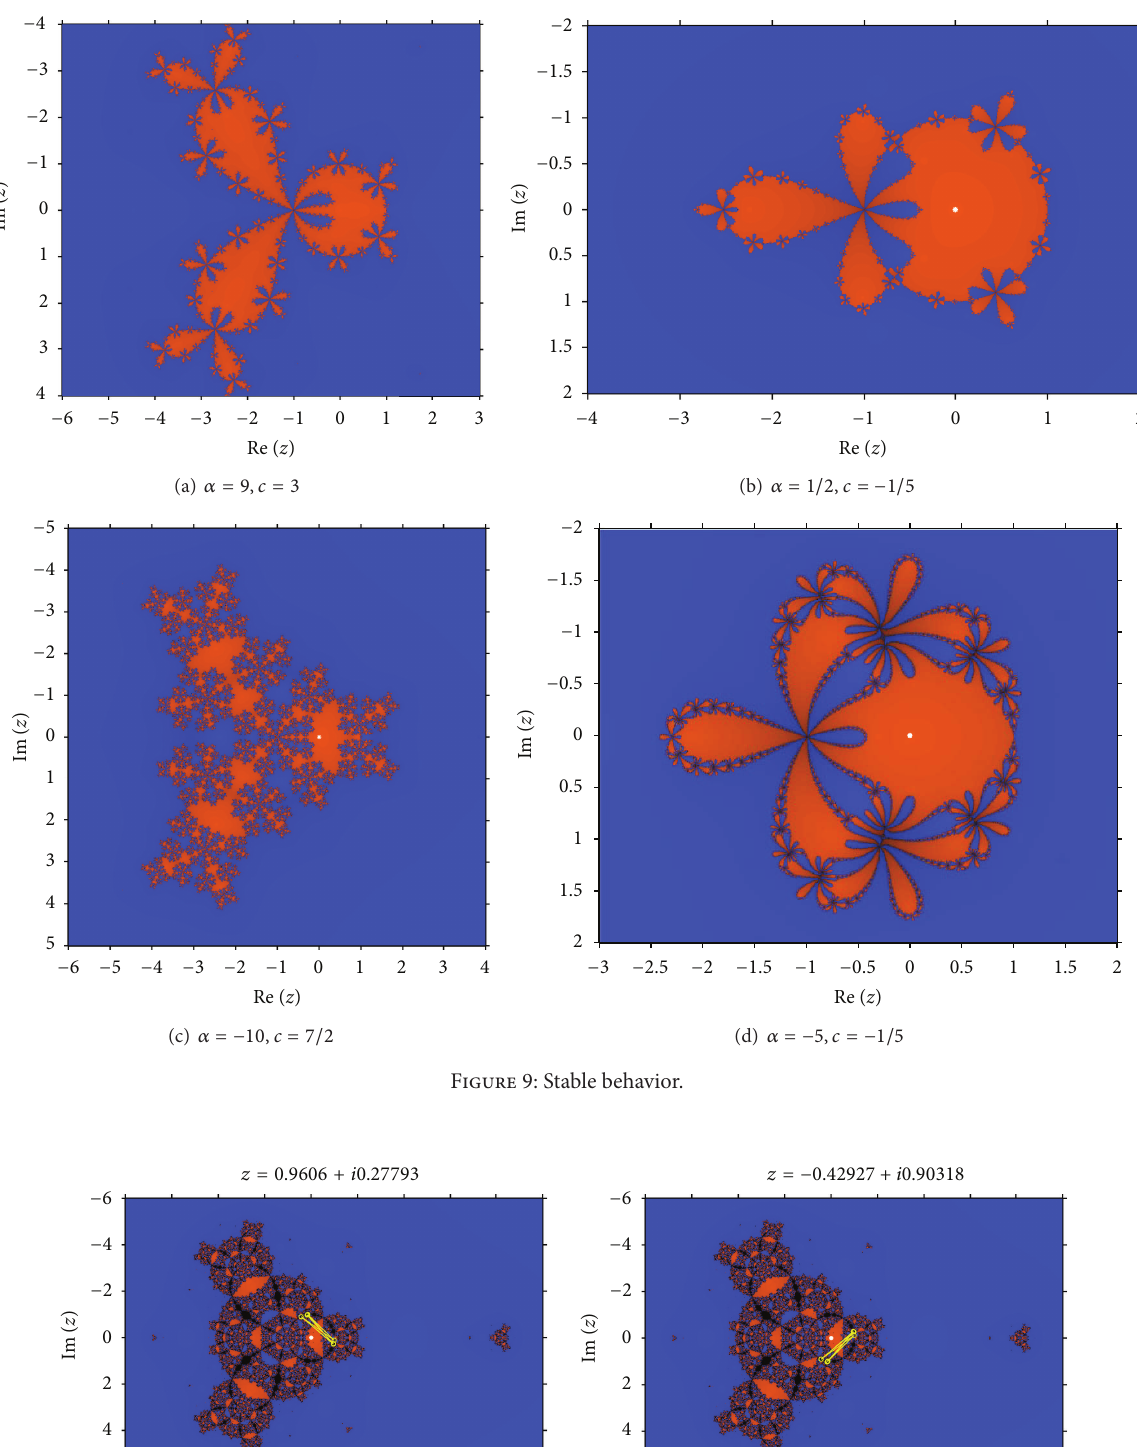
Figure 10: Unstable behavior: two 4-periodic